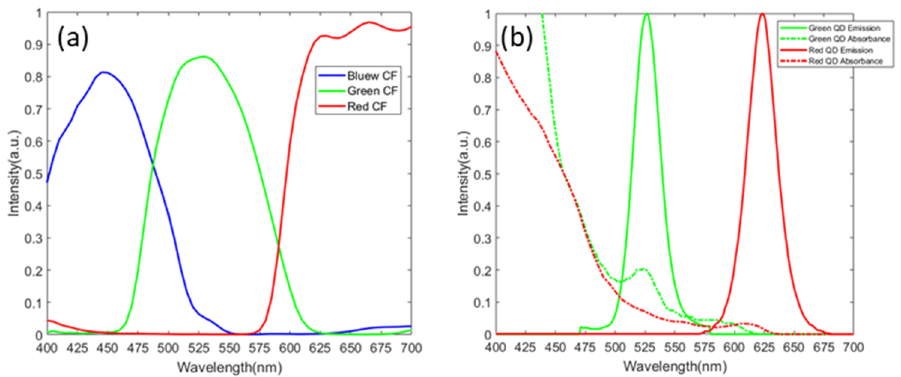
Figure 6. ( a ) The transmittance spectra of color filters and ( b ) the emission and absorption spectra of green and red quantum dots.